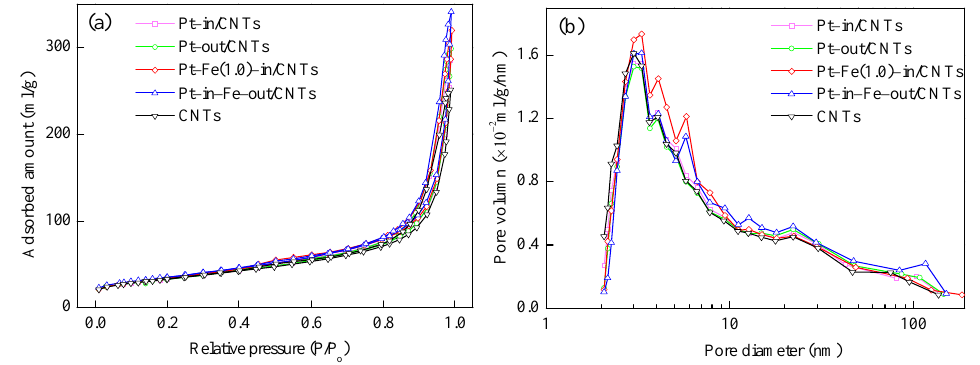
Table 1. Physicochemical properties of carbon nanotubes (CNTs) and catalysts. Figure 2. ( a ) N 2 adsorption–desorption isotherms and ( b ) pore size distribution curves of CNTs, Pt–in/CNTs, Pt–out/CNTs, Pt–Fe(1.0)–in/CNTs, and